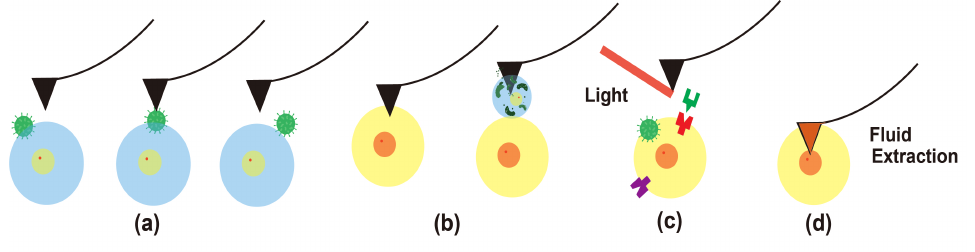
Figure 3. Advanced imaging capability illustration: ( a ) high-speed imaging to track virus movement on cells, ( b ) mechanobiology with viscoelastic property mapping and single-cell force spectroscopy, ( c ) chemical species characterization using near-field optics with AFM, and ( d ) AFM biomedical sample manipulation for fluid extraction from a